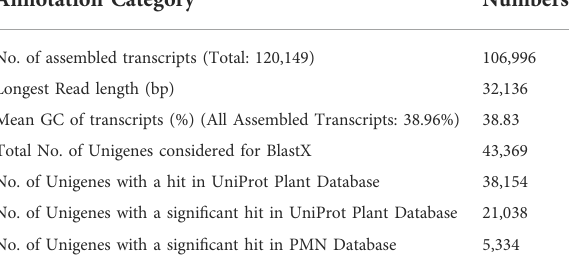
Table S5) using the Blast2GO program (http://www.blast2go.